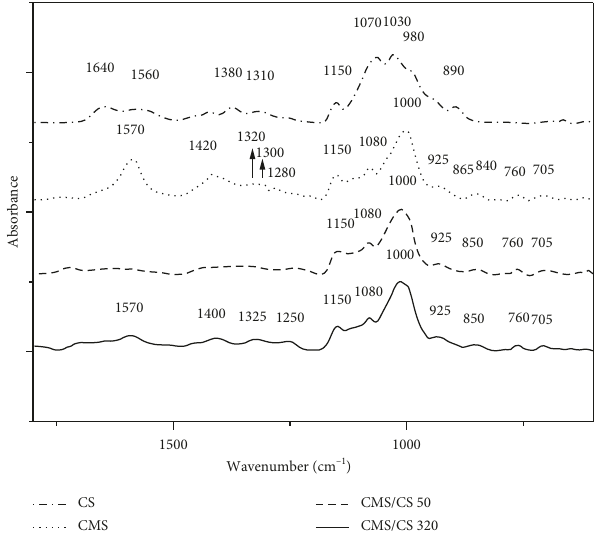
Figure 14: FTIR spectra from CS, CMS, CMS/CS ratio 50, and CMS/CS ratio